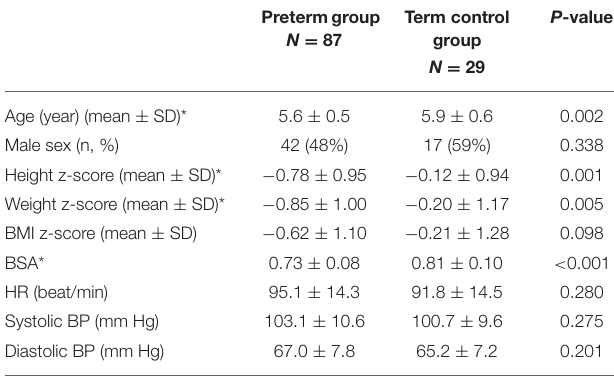
TABLE 1 | Perinatal characteristics of very low birth weight preterm infants who were enrolled in this study.